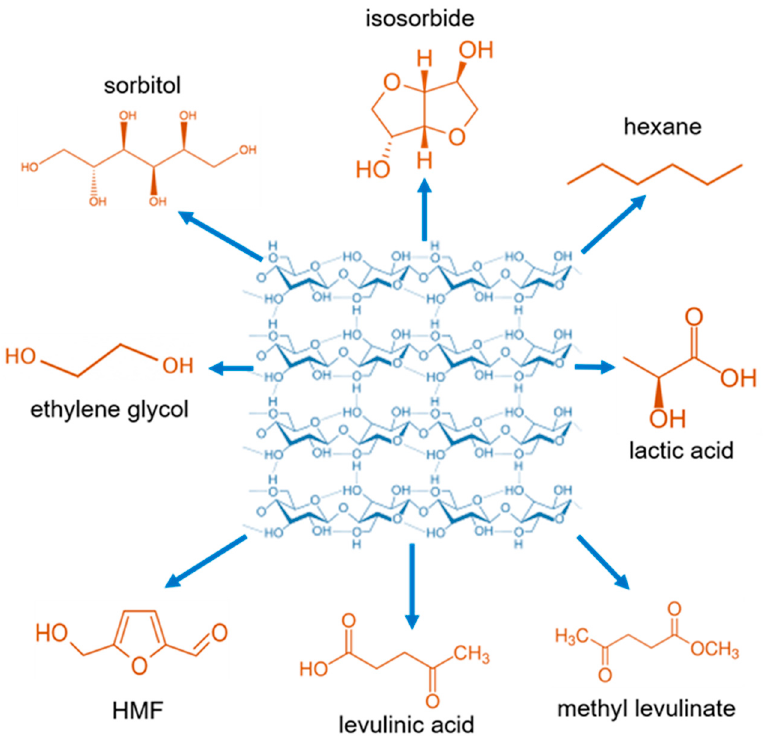
Figure 4. Conversion of cellulose into different molecules catalyzed by niobium compounds. Table 2. Performance of niobium-based catalysts for conversion of cellulose into different prod- ucts—from 2010 to date.